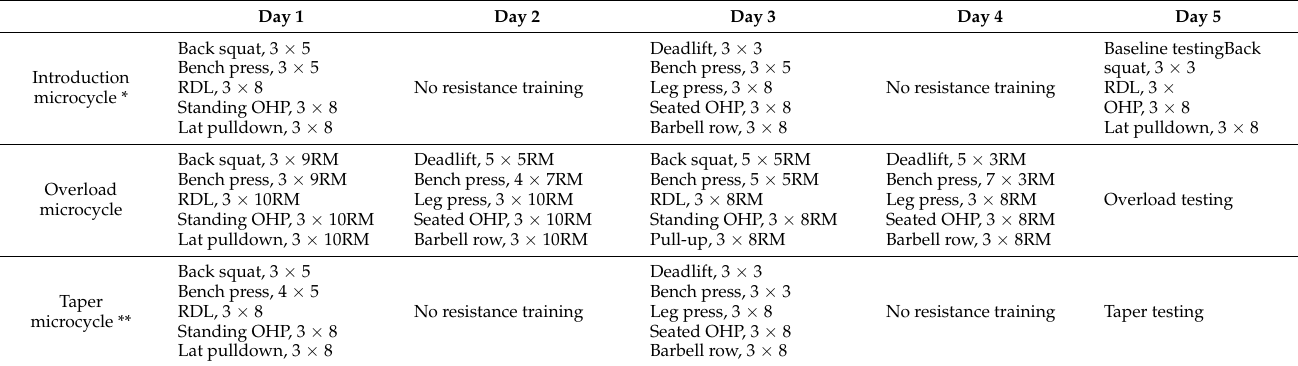
Table 1. Resistance training during introduction, overload, and taper